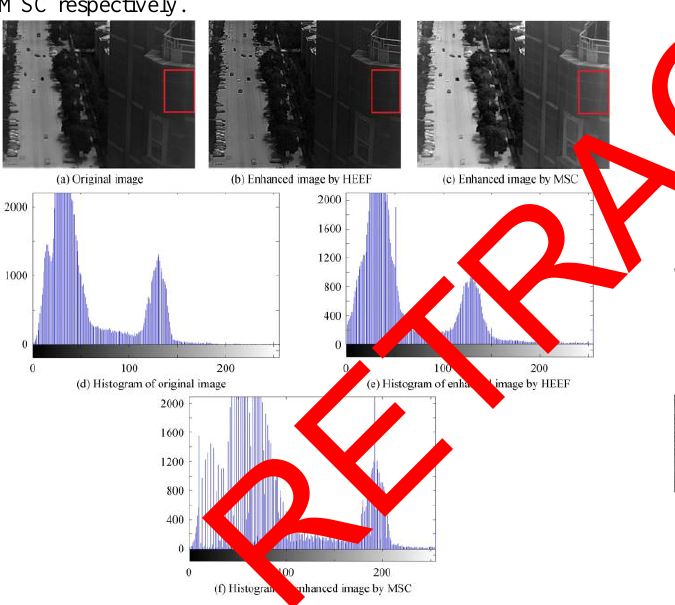
Figure 7. Original infrared images, enhancement results by different methods and their histograms.